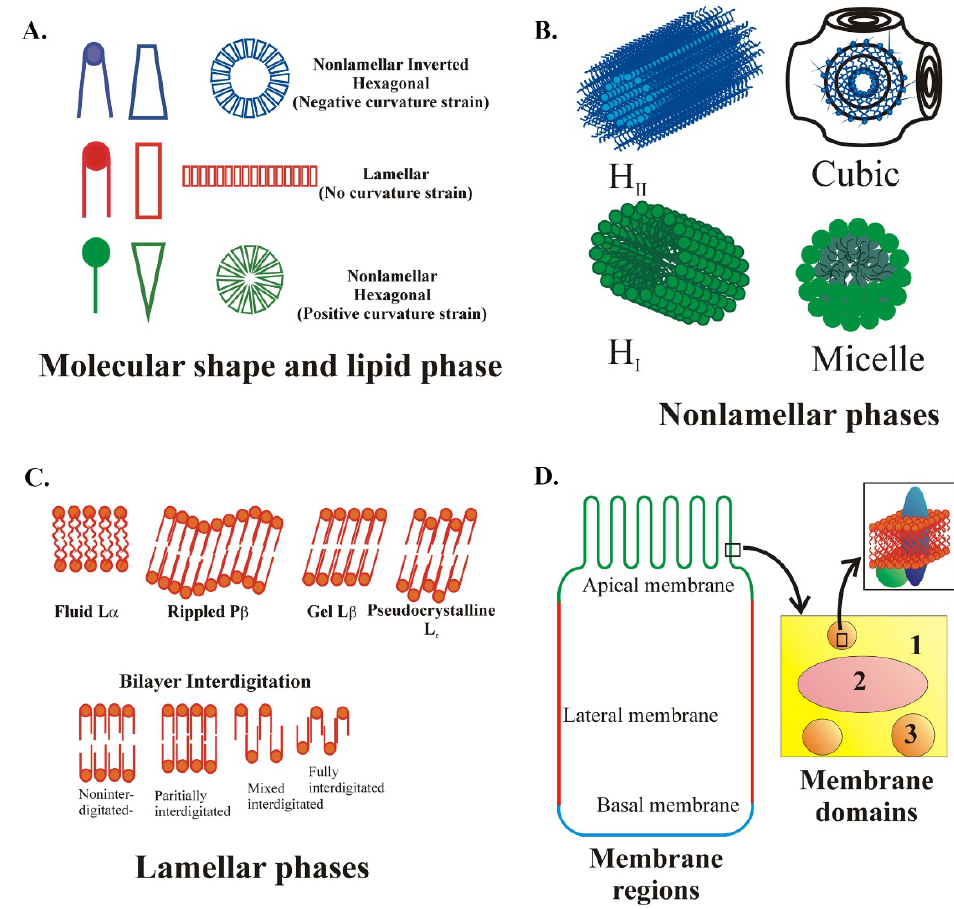
Figure 1. Lipid membrane phases . ( A ) Molecular shape and lipid phases, ( B ) different nonlamellar phases, ( C ) different lamellar phases, and ( D ) polarized cells such as small-intestine endothelial cells. Adapted from [3].